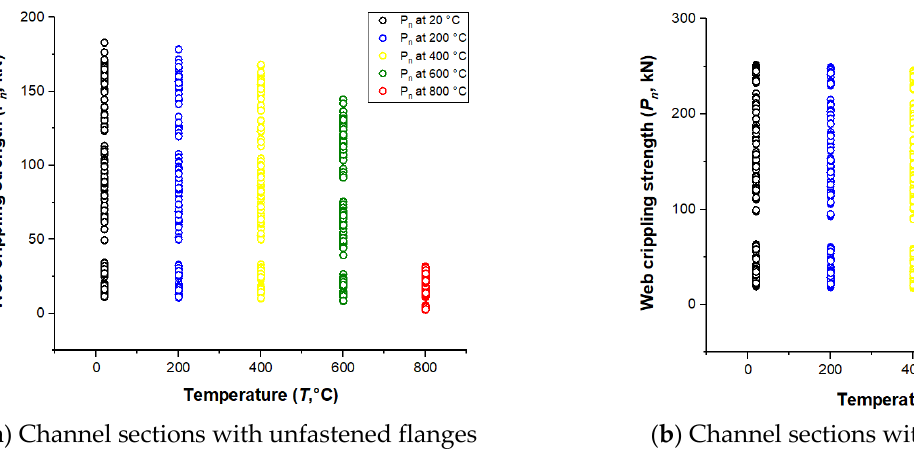
Figure 13. Web crippling strength against temperatures.